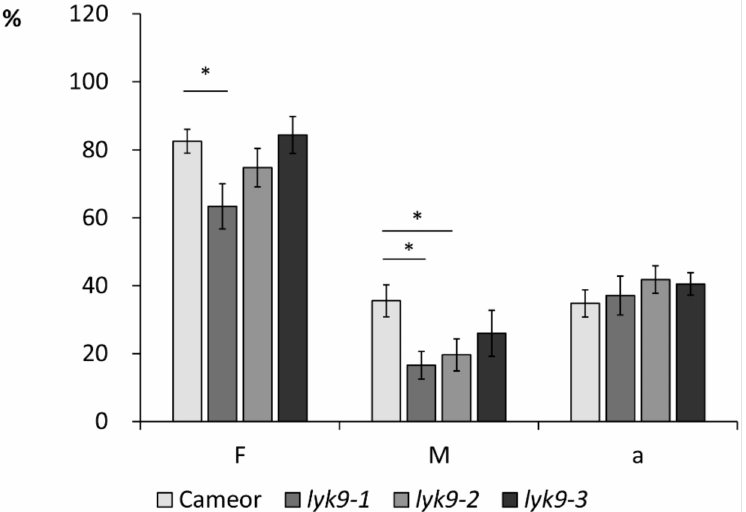
Figure 1. Comparative analysis of root colonization by Rhizophagus irregularis DAOM 197198 in the P. sativum lyk9-1 , lyk9-2 , lyk9-3 mutants and their parental cultivar Cameor. F %—incidence of mycorrhizal infection (colonization), M %—intensity of mycorrhizal (internal) colonization of the root system, a %—arbuscule abundance in mycorrhizal root fragments. The asterisks indicate statistically significant differences based on one-way analysis of variance (one-way ANOVA), followed by Tukey post-hoc test (* p <